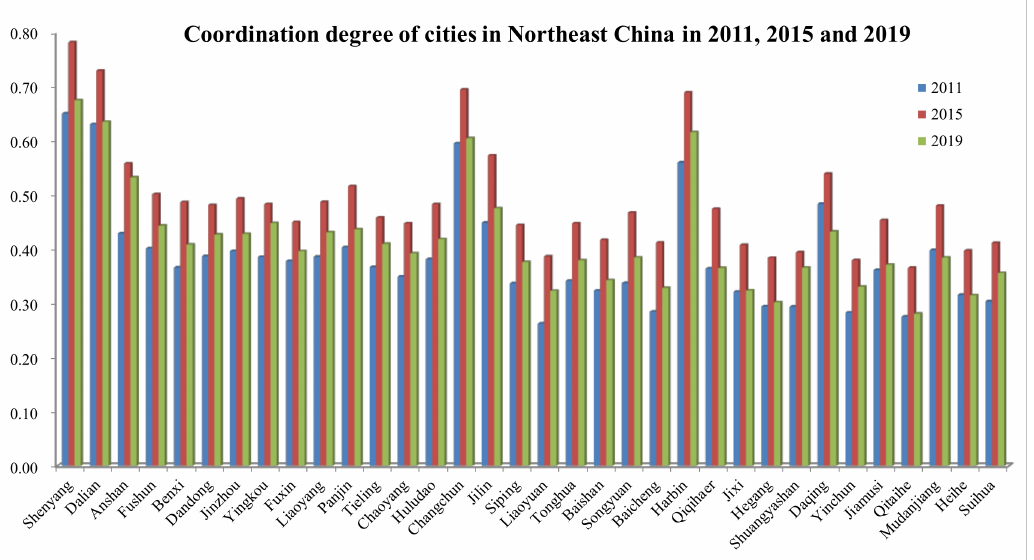
Figure 5. The evolution of coupling coordination degree of urban PHSs and RHSs of cities in northeast China in